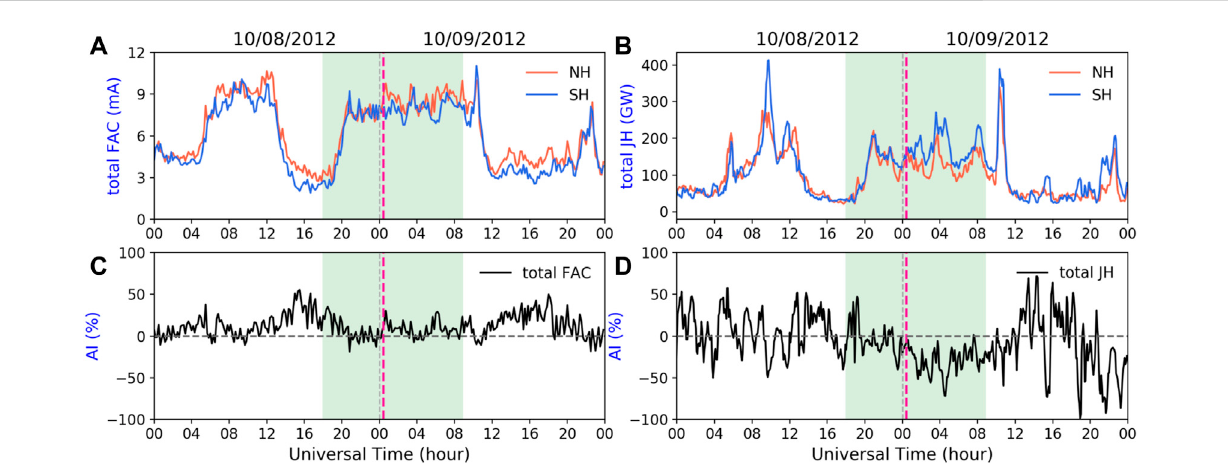
FIGURE 10 Inter-hemispheric comparisons of the total fi eld-aligned current (FAC, (A) , total Joule heating (B) , and their corresponding asymmetry index (AI, (C, D) during the October 8 – 9, 2012, geomagnetic storm. All the results are from run 2 (driven by data-based realistic patterns) since run 2 has obvious advantages in reproducing the high-latitude forcing. The vertical purple dashed line marks the IMF B y reversal time during the storm main